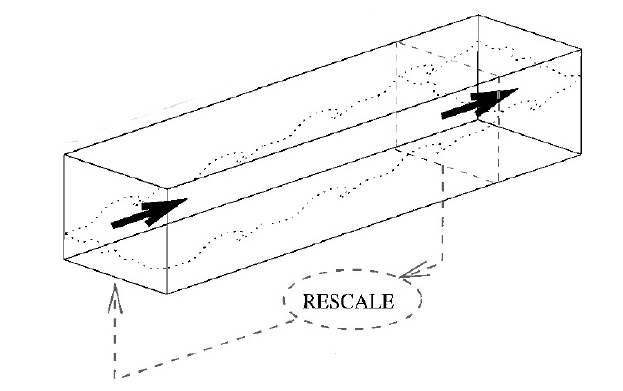
Figure 1. Computational domain with recycling-rescaling